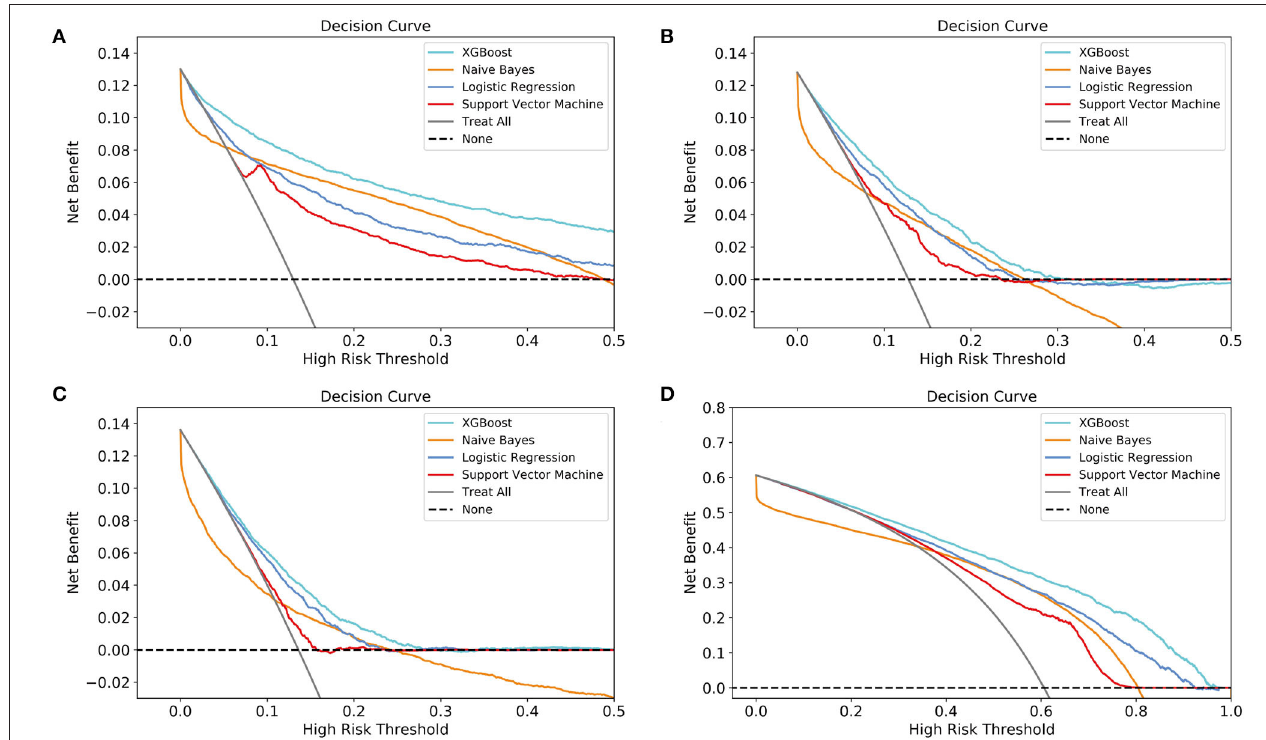
FIGURE 5 | Decision curve analysis (DCA) of the four prediction sub-models. (A) class 0 ( < 30 days); (B) class 1 (30 days − 1 year); (C) class 2 (1–5 years); (D) class 3 ( ≥ 5 years). The net benefit curves for the four prognostic sub-models are shown. The lateral-axis shows the threshold probability for different class outcomes, and the direct-axis shows the net benefit. The horizontal dashed line represents no intervention in all patients, with a net benefit of 0, and the sloping gray line represents intervention in all patients. The four colored curves represent the four schemes (prediction models) with a larger net benefit to XGBoost compared to the other models for the threshold probabilities of different